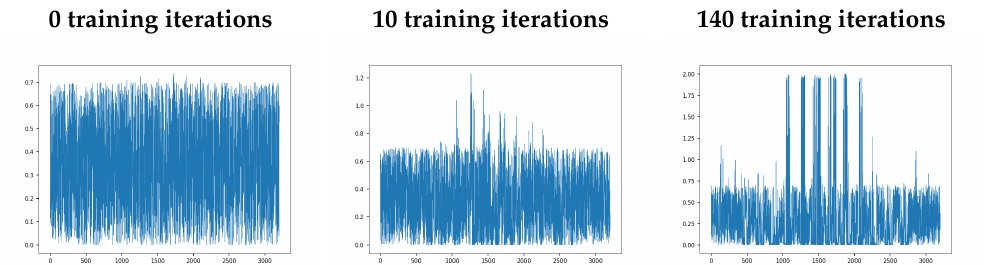
Figure 9. Progression of weight connections between the hidden layer and output layer as STDP operates during the training period. The Y -axes display the weights of synaptic connections, and the X -axes display synapse indexes. In this example, w max = 2.0.